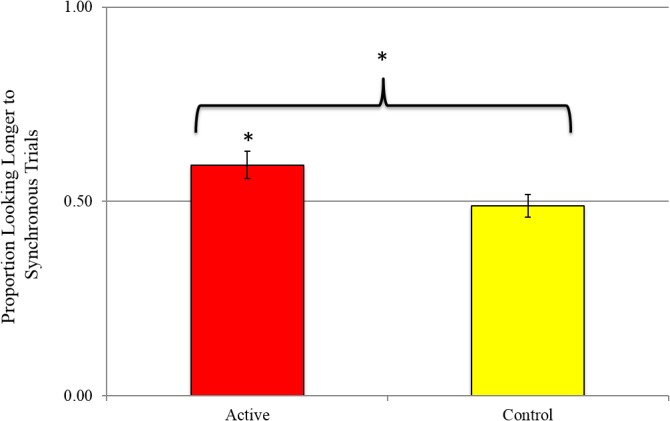
Experiment 1 results.Infants in the Active and Control conditions differed in the proportion of trials in which they looked longer to the synchronous videos. (*p < .05, chance = 50%, error bars represent standard errors).